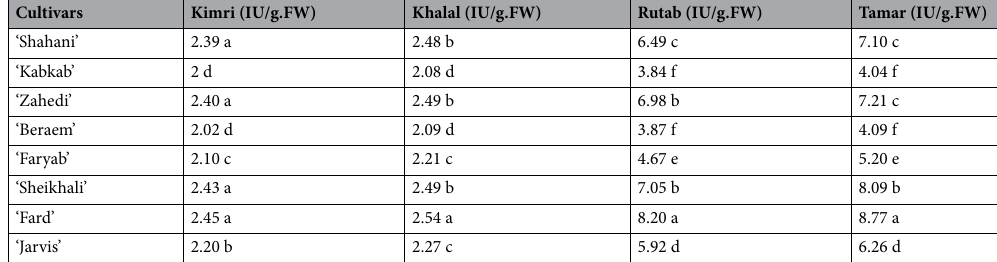
Table 9. Polygalacturonase enzyme activity of ‘Piarom’ date fruit in kimri, khalal, rutab and tamar stages after pollination with eight pollinating cultivars. Different letters within columns indicate significant differences according to Duncan’s multiple range test (p <